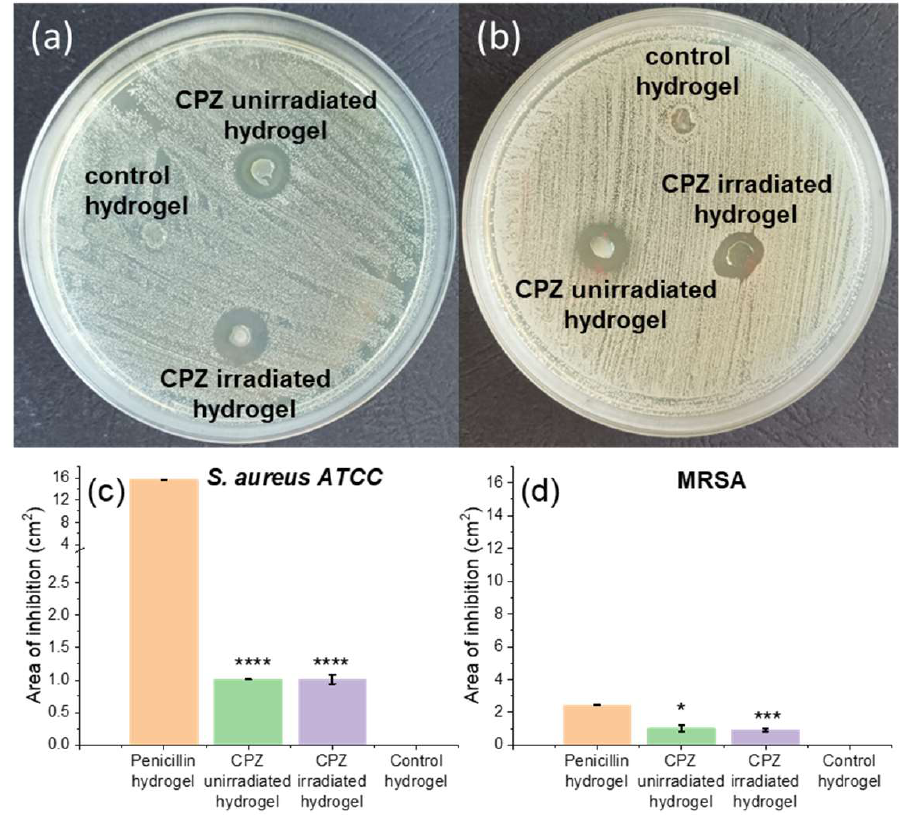
Figure 10. Disc diffusion sensitivity test of unloaded GelMa hydrogel and GelMa hydrogels loaded with 2 mg/mL unirradiated CPZ and 2 mg/mL irradiated for 30 min CPZ against ( a ) S. aureus , ( b ) MRSA. Area of inhibition and corresponding standard deviation of the GelMa hydro- gels loaded with penicillin (positive control), unirradiated and irradiated CPZ against ( c ) S. aureus and ( d ) MRSA strains. Data expressed as mean ± SD, n = 3, data points analyzed by t-test, levels of statistical significance between the penicillin and unirradiated/irradiated CPZ groups of **** p < 0.0001, * p < 0.05, *** p < 0.0005.